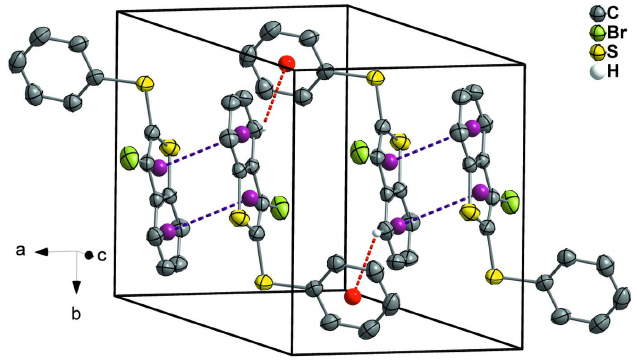
Figure 9 Representation of some molecules of 3-bromo-2-(phenylsulfanyl)benzo- [ b ]selenophene ( 1 ) viewed approximately down the c axis of the unit cell. The red dashed lines represent C—H (cid:2)(cid:2)(cid:2) (cid:3) interactions involving the H5 atom of the benzo[ b ]thiopehene ring with an adjacent phenylsulfanyl group; the purple dashed lines represent (cid:3) – (cid:3) stacking interactions between adjacent benzo[ b ]thiopehene rings. Displacement ellipsoids are drawn at the 50% probability level. The hydrogen atoms, except for H4, are omitted for clarity. Red and purple spheres represent the centroids of the respective organic groups.